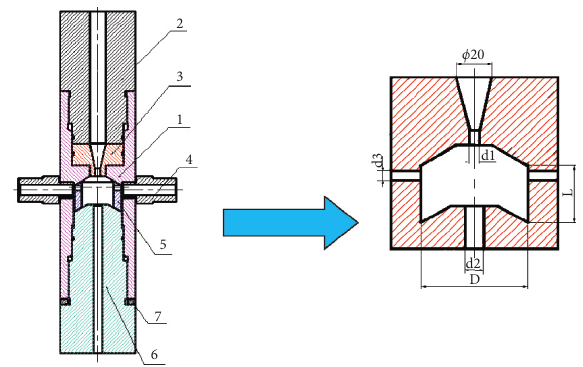
Figure 2: The experimental tool of the pulsed abrasive jet. (1) Body; (2) top connector; (3) upper nozzle; (4) drawing entrance; (5) sleeve; (6) lower nozzle; (7)